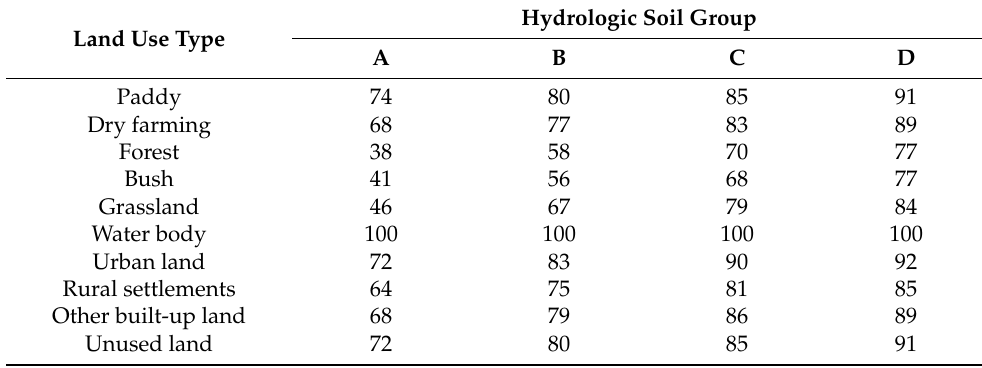
Table 3. CN values under different hydrologic soil groups and land use types.